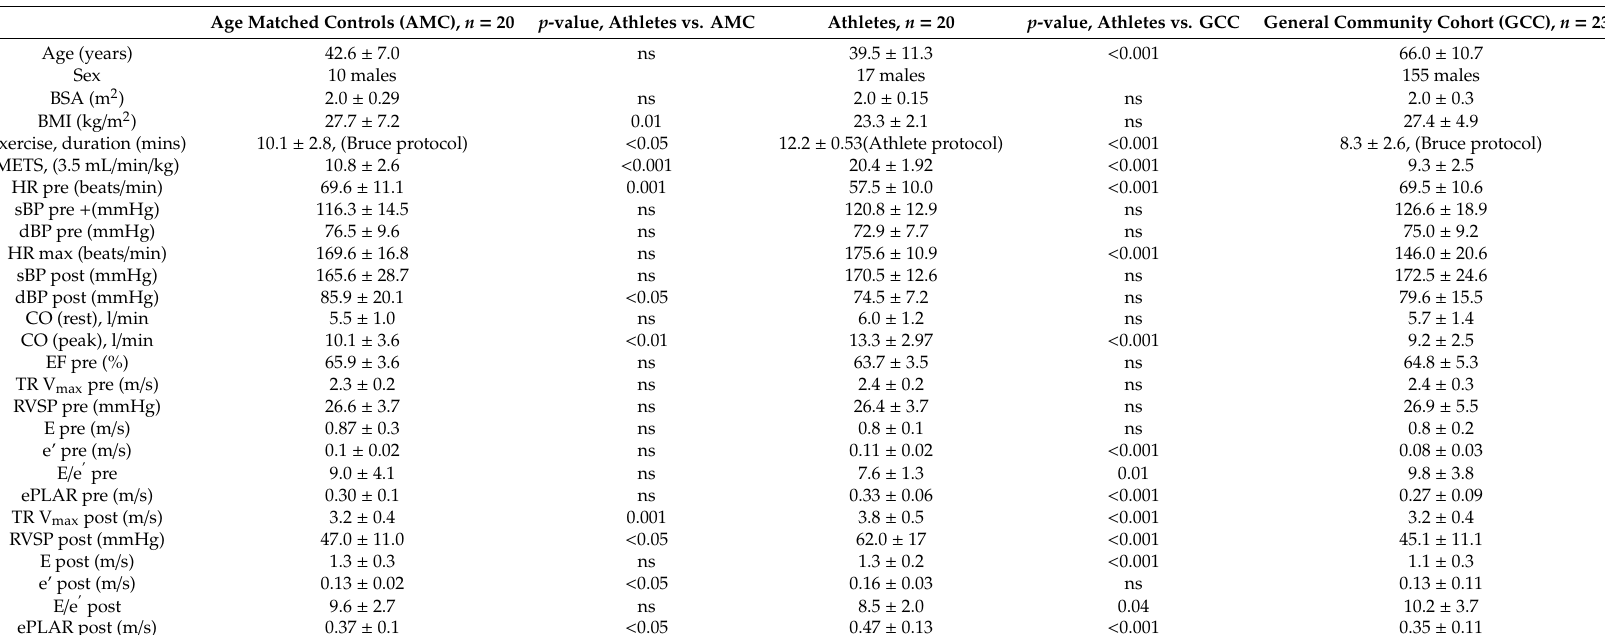
Table 1. Mean data and corresponding p -values of 20 age matched controls vs. 20 athlete population vs. 230 non-athlete population undergoing treadmill exercise stress